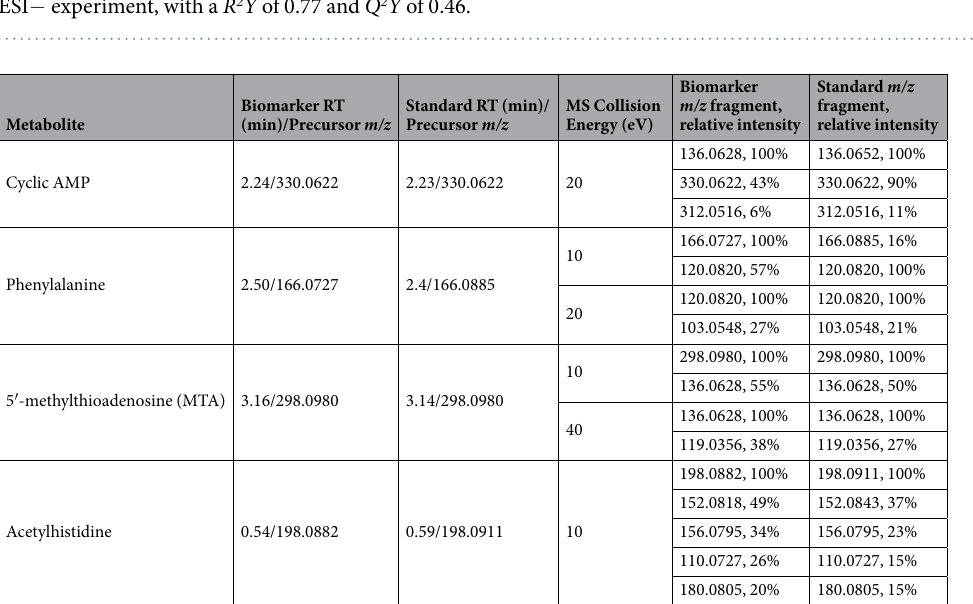
Figure 4. Multivariate data analysis of urine metabolomics data. ( A ) Scores plot of ESI + measurements. The urine samples from diabetes subjects (T2D) and controls were found to be well separated along the predictive component axis with an explained variance ( R 2 Y ) of 0.84 and predictability ( Q 2 Y ) of 0.36. ( B ) Scores plot of ESI − experiment, with a R 2 Y of 0.77 and Q 2 Y of 0.46.